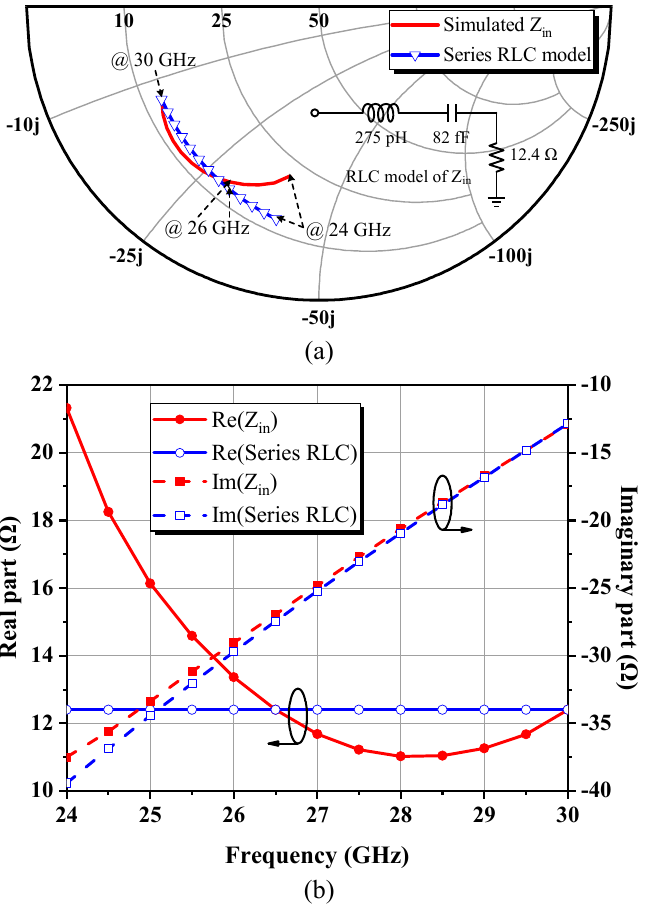
Figure 12. ( a ) Simulated S 11 of the stabilized 50 × 2 µ m cell and series RLC equivalent circuit. ( b ) Comparison of the real and imaginary parts of Z in and RLC model circuit impedance.